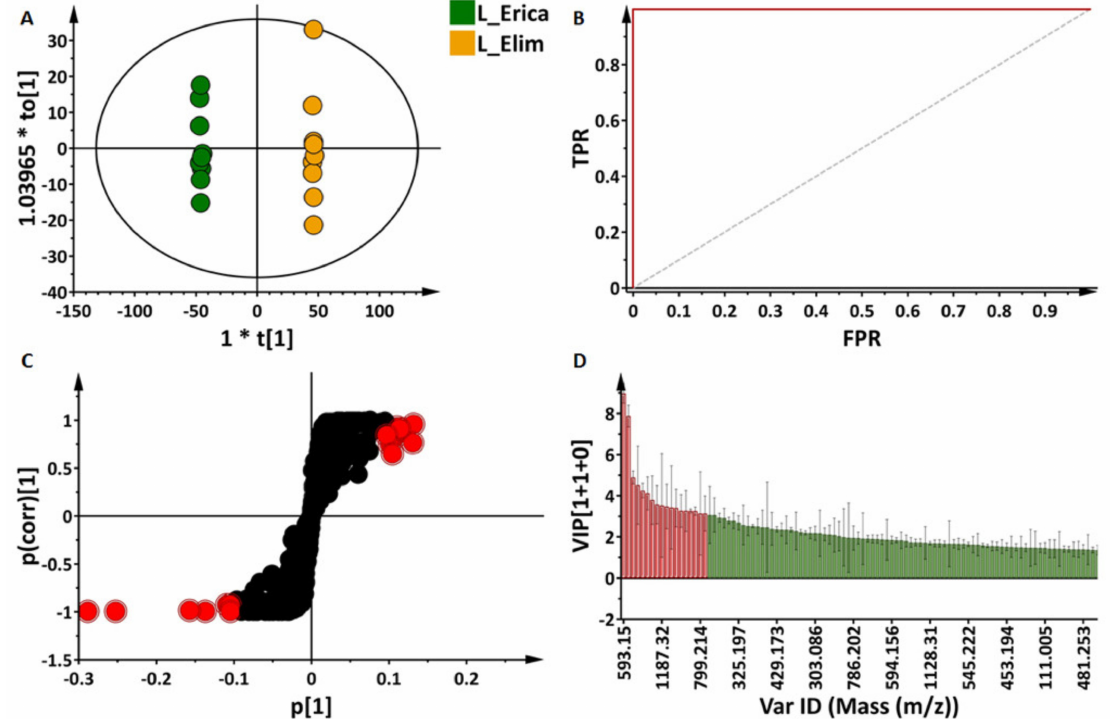
Figure 6. Supervised multivariate data analyses of ultra-high performance liquid chromatography—mass spectrometry (UHPLC-MS) data. Orthogonal partial least squares discriminant analysis (OPLS-DA) modelling and feature selection were performed, based on the unique metabolite profiles of ‘Erica’ and ‘Elim’ leaf extracts in negative ionisation mode. ( A ) OPLS- DA score plots showing a clear separation between the two cultivars. The model is made of 1 predictive component and 1 orthogonal component (R 2 X = 66.4%, R 2 Y = 99.9%, Q 2 = 99.7%, CV-ANOVA p -value = 7.78e − 16 ). ( B ) Receiver operator characteristic (ROC) plot summarising the performance of the binary classifier. Perfect discrimination is characterised by a ROC plot showing 100% specificity and sensitivity as above. ( C ) Loading S-plots displaying the features responsible for sample clustering, and are located at the ‘outlier’ ends of the S-plots, highlighted in red here. These features are statistically significant candidates as biomarkers for both cultivars. ( D ) Variable importance in projection (VIP) plot corresponding to the model above and pointing out the mathematical significance of each feature responsible for the discrimination of the cultivars. A VIP score > 1 is considered as significant in the projection and the higher the score values, the more significant the features